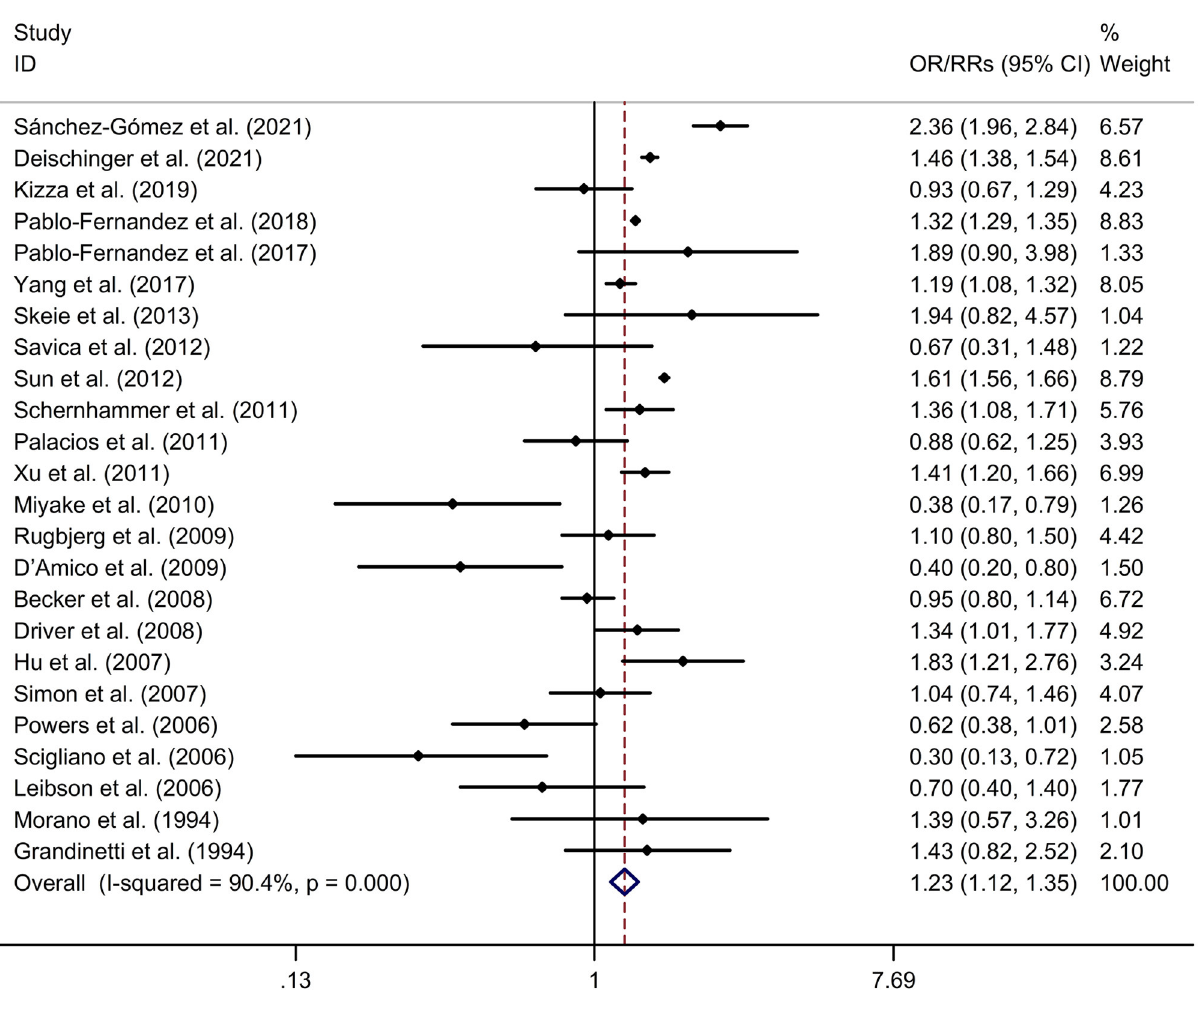
1.92, 95% CI 1.45–2.55, p < 0.001, I 2 = 50.3%, p -value for